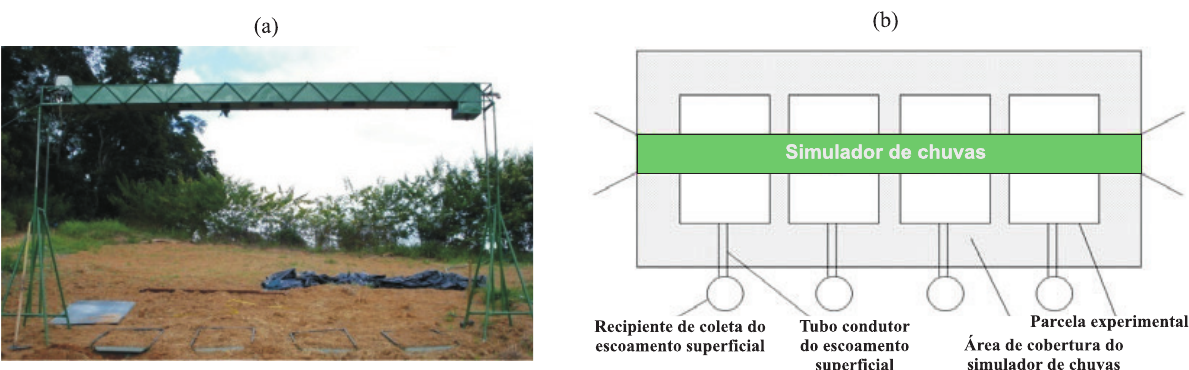
figura 1. Simulador de chuvas utilizado no experimento (a) e arranjo das parcelas para a realização dos testes de infiltração (b).